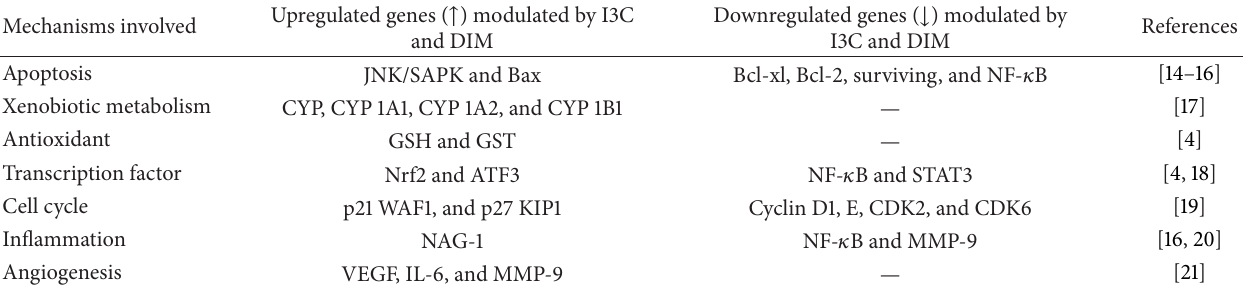
Table 1: Modulation of genes involved in various mechanisms by the influence of I3C and DIM. Mechanisms